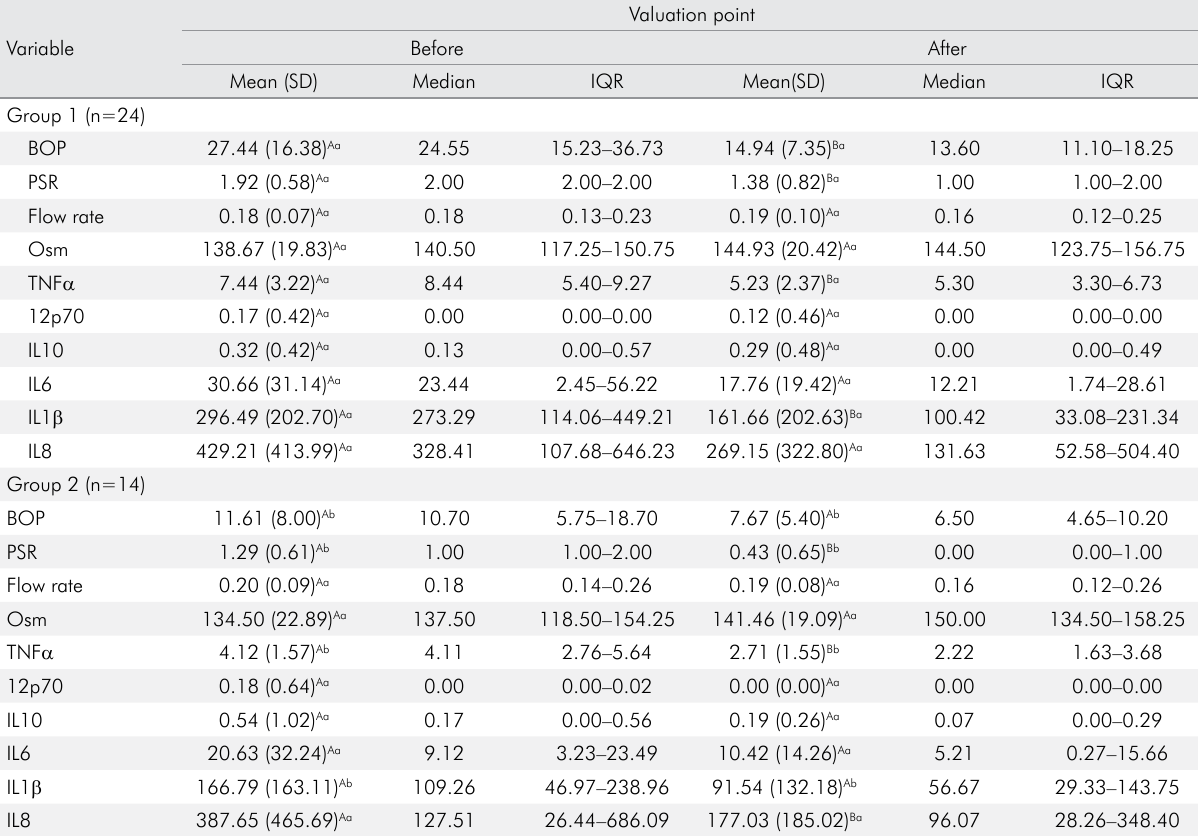
Table 2. Comparative analysis of the periodontal condition, salivary flow, salivary osmolality and salivary concentrations of